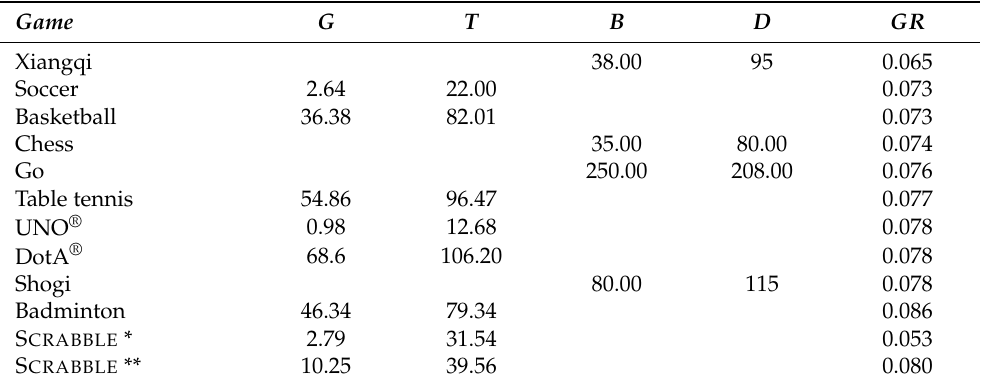
Table 3. Correlative measures of legacy game refinement (GR) measures (ordered by game refine- ment value).